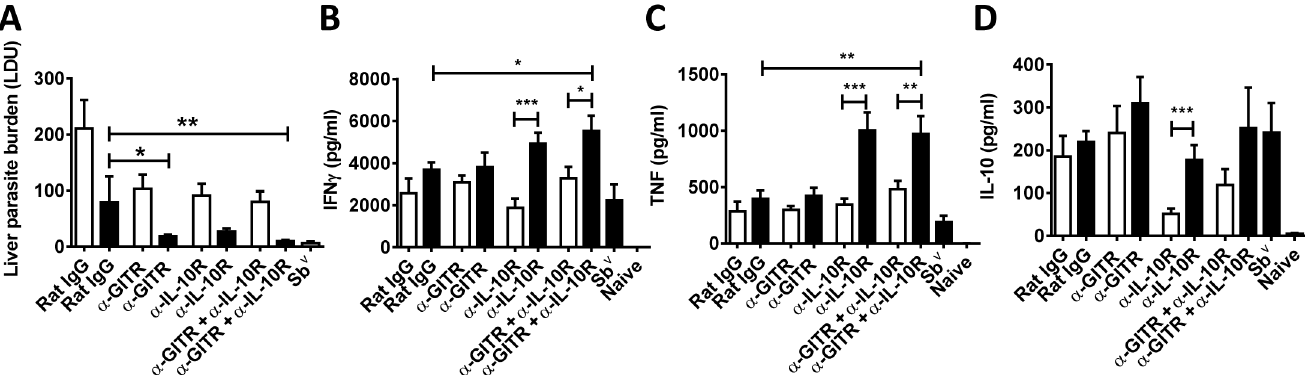
Fig 6. The effects of different immune and drug therapy combinations. L . donovani -infected mice (low-dose challenge with 5 x 10 6 parasites) were treated either with control Ab, anti-GITR mAb, anti-IL-10R mAb or both mAbs with (black bars) or without (open bars) a sub-optimal dose of sodium stibogluconate (Sb v ). A group receiving a full dose of Sb v was also included. Infected mice were treated with anti-GITR mAb on day 14 p.i., and anti-IL-10R mAb on days 14, 19 and 24 p.i., with or without drug, as indicated. Rat IgG was used as a control. Liver parasite burdens were measured at day 28 p.i. (A). Spleen cells were also isolated at this time and cultured with parasite antigen for 24 hours before measuring levels of IFN γ (B), TNF(C) and IL-10 (D) in culture supernatants. Data are represented as the mean +/- SEM, and statistical differences of p < 0.05 ( * ), p < 0.01 ( ** ) and p < 0.001 ( *** ) are indicated (n = 6 mice per group, one independent experiment from 1 – 3 independent